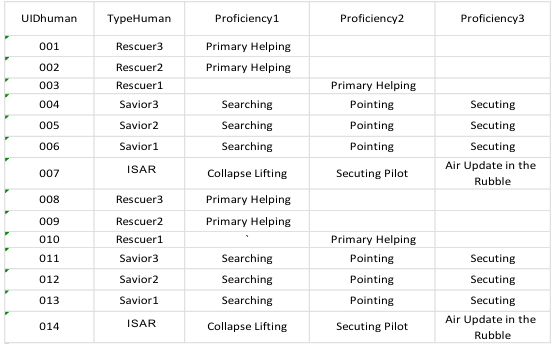
Figure 5: Descriptive information of relief workers